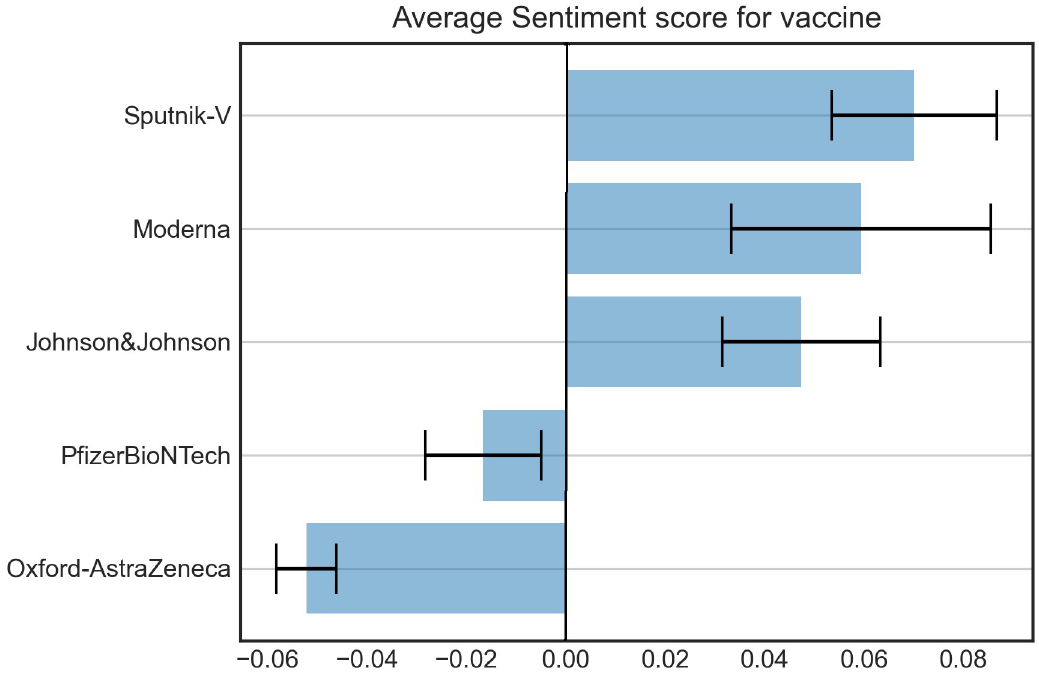
Fig 6. Average sentiment score by COVID-19 vaccines brand. The error bar indicates the relative standard error from the mean.